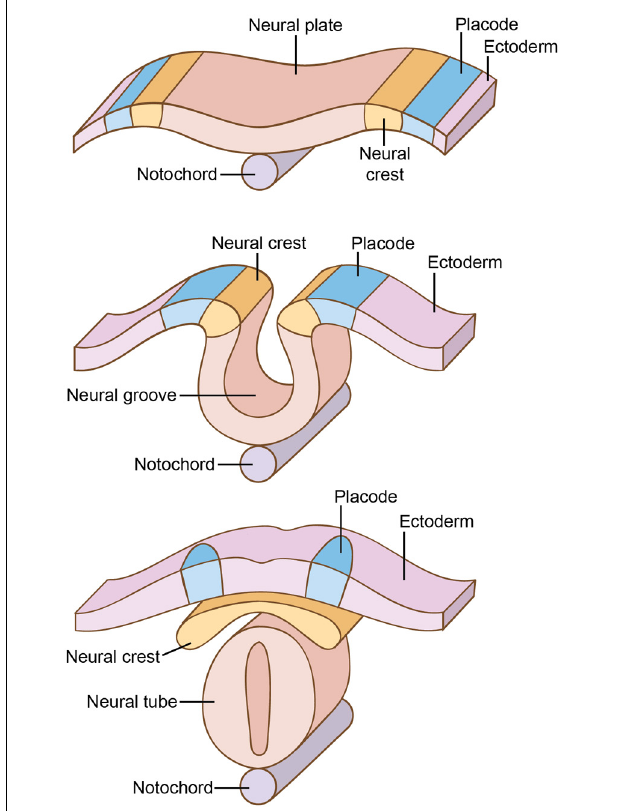
FIGURE 3 | Development of the neural crest and placodes, near the midline of the back. In vertebrates, double-walled folds form at the anterior and lateral regions of the neural plate, the inner walls of which give rise to the neural crest while the lateral folds give rise to the neurogenic placodes